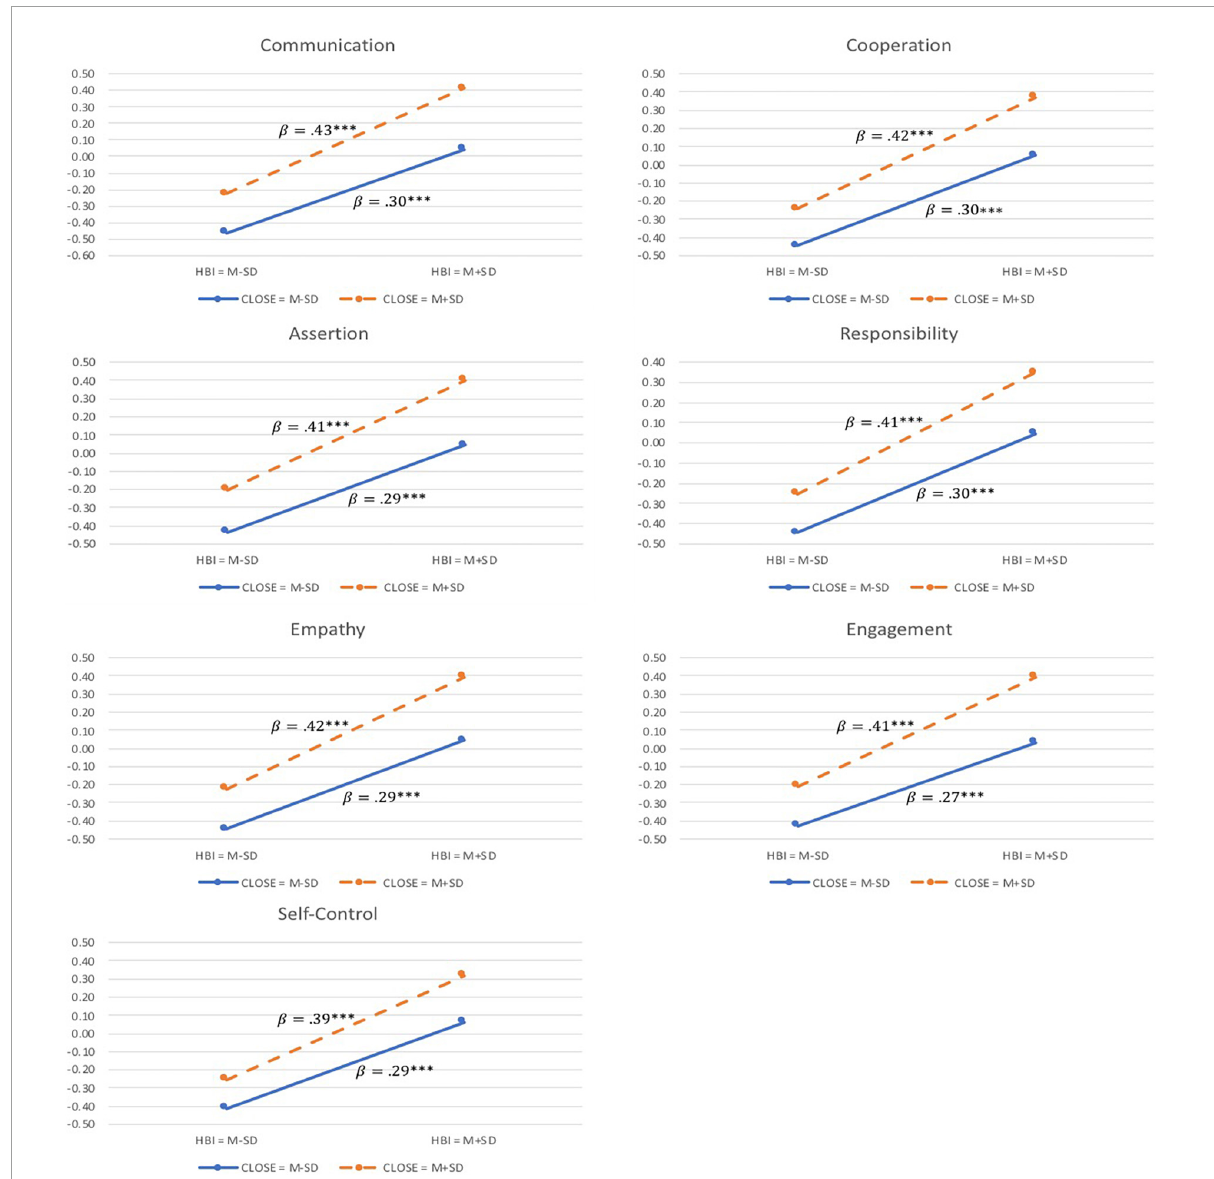
FIGURE2 Moderation effect of parent-child closeness on the impact of home-based involvement on preschoolers’ social skills. β s are regression coefficients of Home-based Involvement from simple slope analyses. *** p <